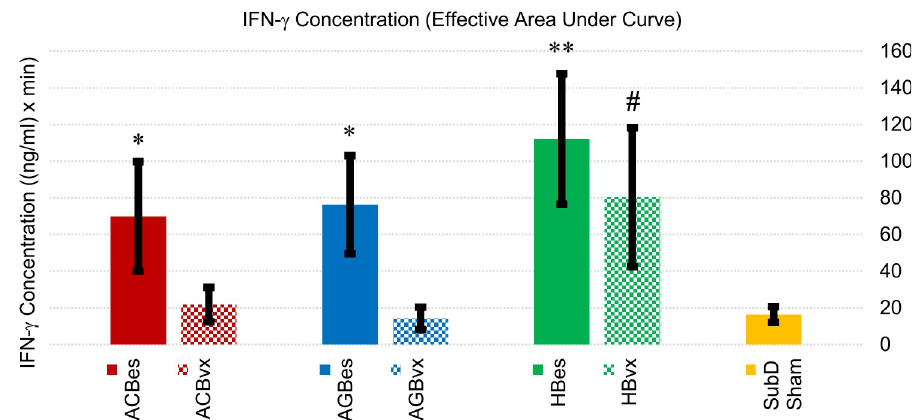
Fig 11. Cumulative IFN- γ concentration effects of subgroup responses to IP injection of LPS (5 mg/kg). Values represent effective areas under the curve for each subgroup shown in Fig 10. Error bars, s.e.m. # p < 0.1 compared to SubD Sham group. � p < 0.05 compared to SubD Sham group. �� p < 0.01 compared to SubD Sham